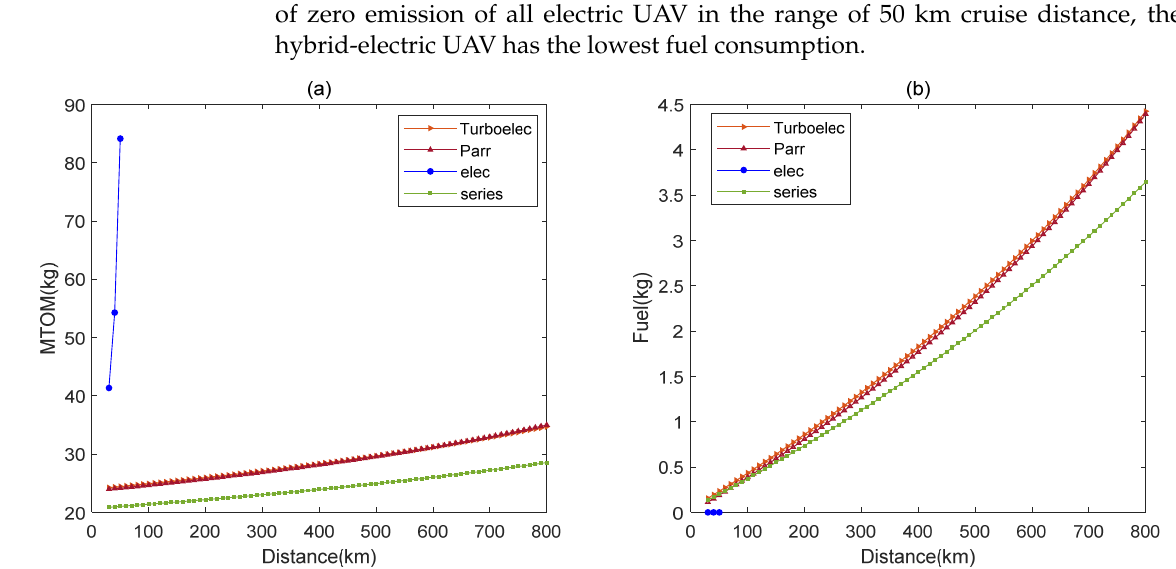
Figure 9. Effect of cruise distance: ( a ) MTOM; ( b ) fuel consumption.